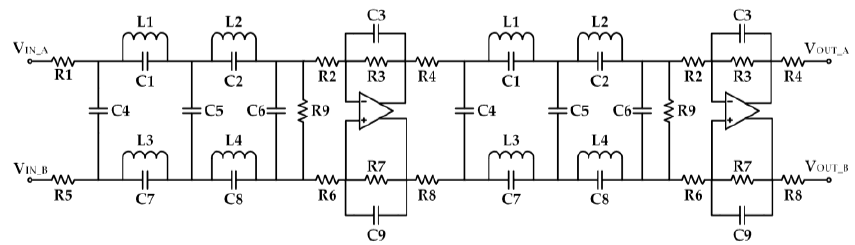
Figure 3. Schematic of the fully differential low ‐ pass filter (LPF). The LPF comprised two cascading fifth ‐ order elliptic type LC filters.